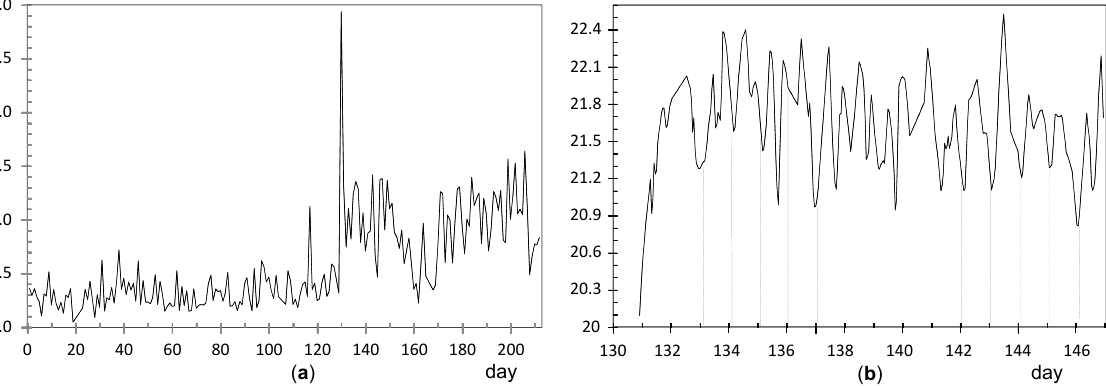
Figure 11. Node CH2: ( a ) time series of daily ranges of temperature ( ° C) for the 212 days, ( b ) time series of hourly values of temperature from day 130 (8 December) until day 146 (24 December).